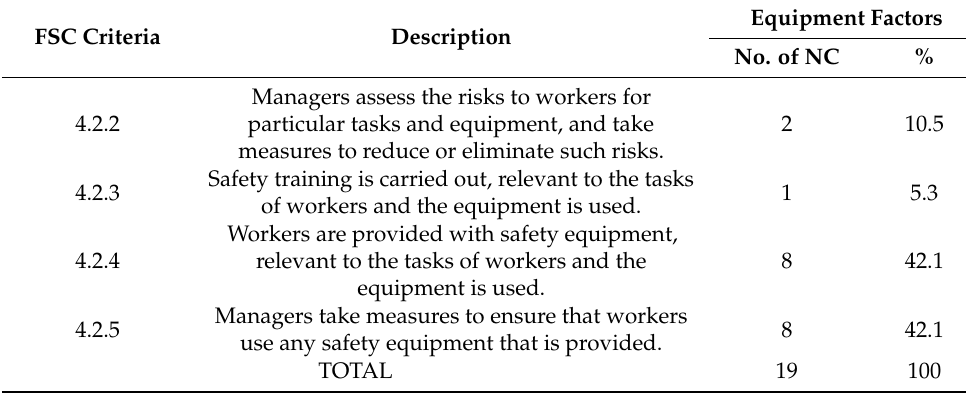
Table 2. Analysis of the NCs related to equipment risk-factor category and their relation to the FSC